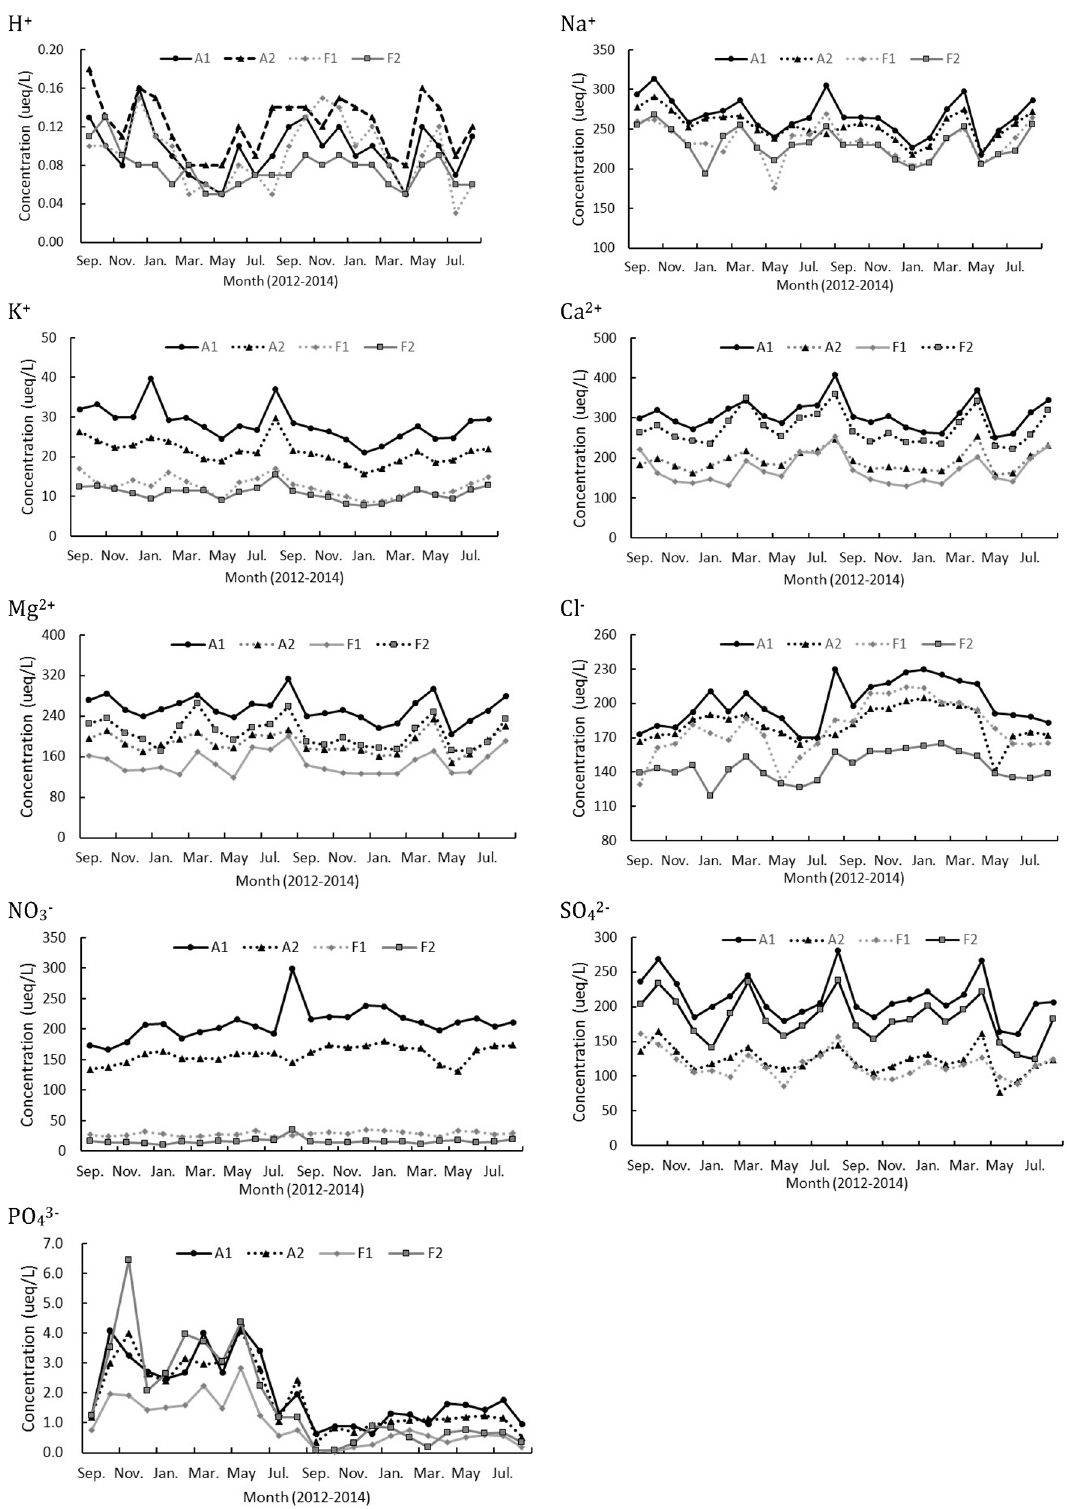
Figure 2. Monthly ion concentration (volume-weighted from weekly samples) of streamwater of watersheds A1, A2, F1, and F2.